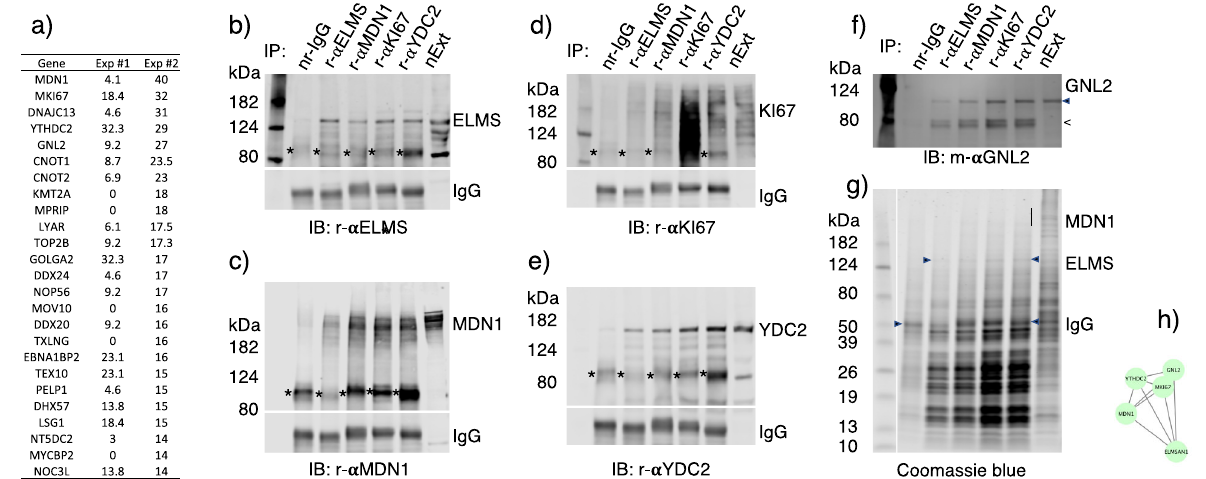
Fig. 3 Reciprocal IP. a Enrichment of proteins by two independent IP – MS experiments. The top 25 highest enriched proteins in Exp #2 and Exp #1 are shown in the table. b – f IP was carried out with rabbit anti-ELMSAN1 (r- α ELMS), rabbit ani-MDN1 (r- α MDN1), rabbit anti-MKI67 (r- α KI67), and rabbit anti- YTHDC2 (r- α TDC2) antibodies, respectively. IB of the immunoprecipitates was carried out with these antibodies and mouse monoclonal anti-GNL2 (m- α GNL2) antibody, respectively. The bands indicated by < appear to have occurred during the experimental process. g Coomassie blue staining of the immunoprecipitates. h A model of the complex consisting of MKI67, GNL2, YTHDC2, MDN1, and ELMSAN1. This model is derived from evaluation of the reciprocal IP yields (Supplementary Table